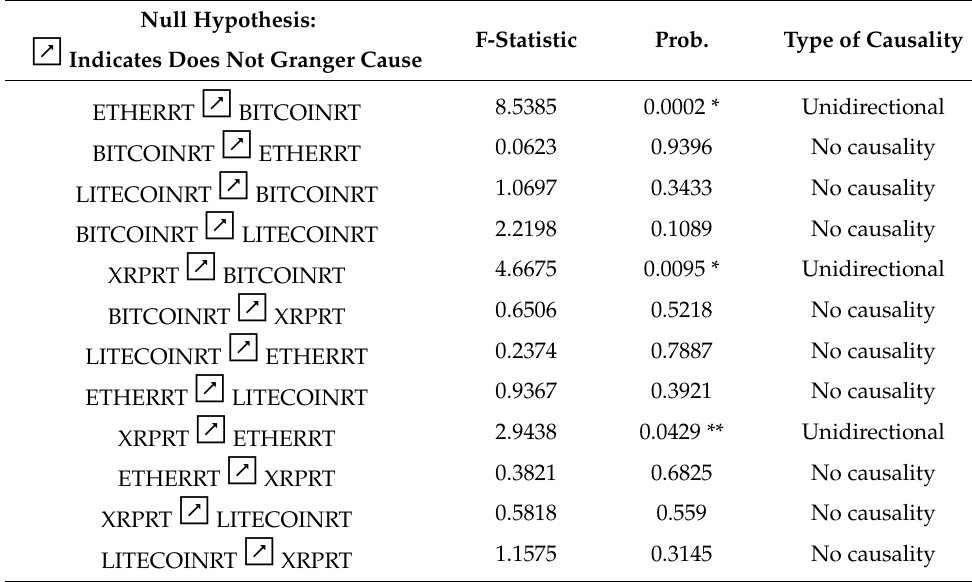
Table 7. Granger Causality among Cryptocurrencies. Null Hypothesis: